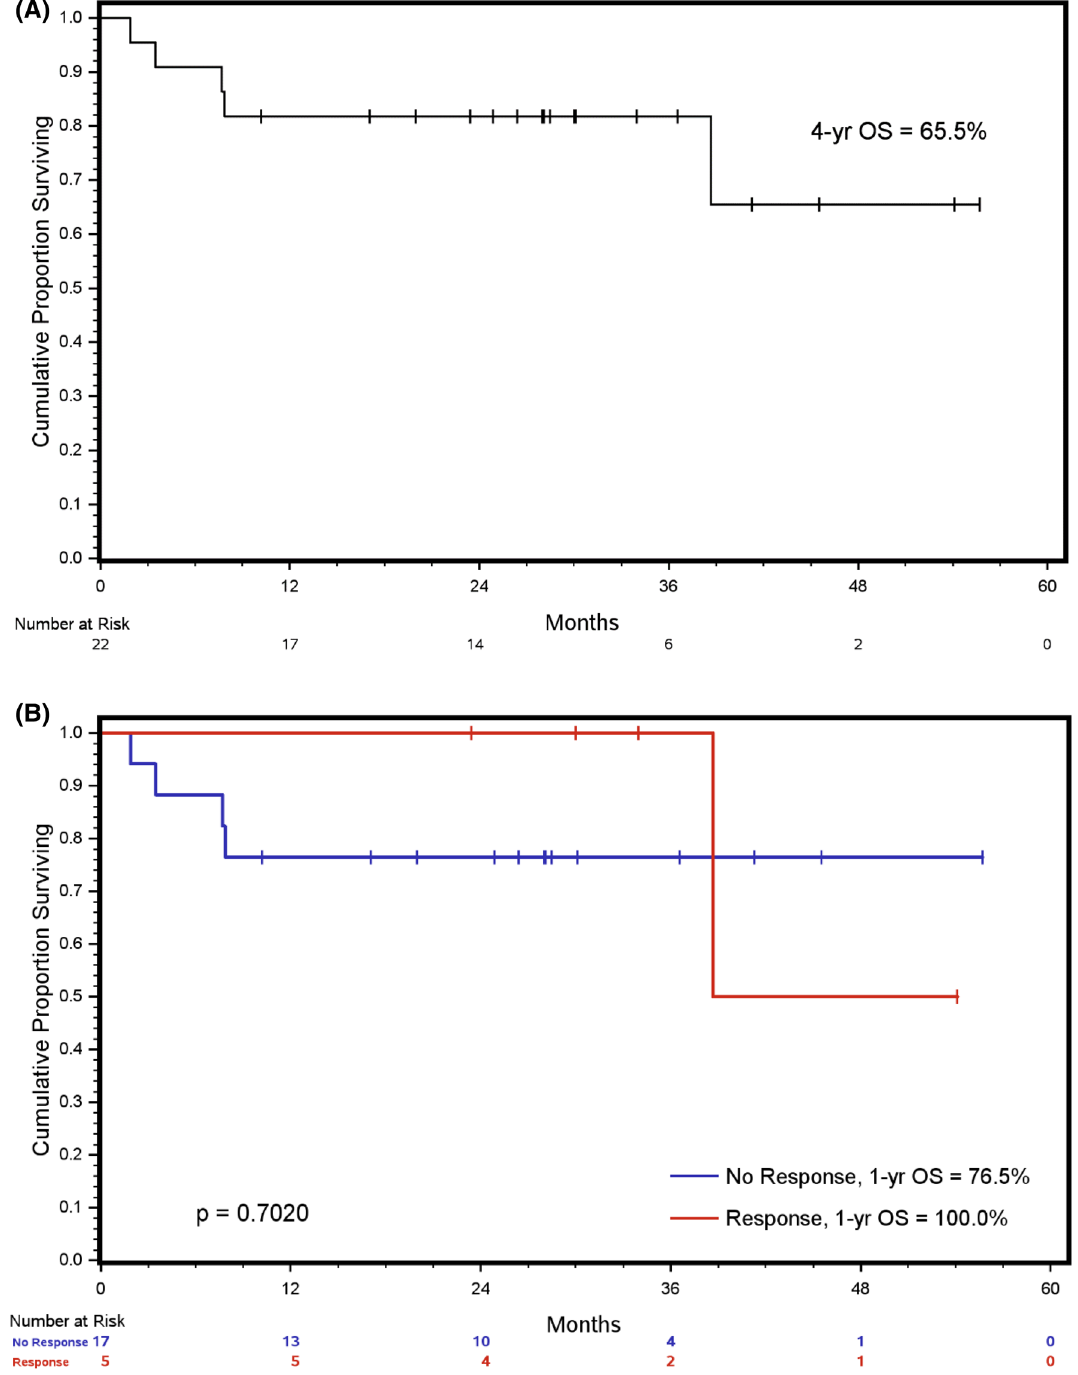
Figure 2. ( A ) OS from the date of first treatment. Estimated OS at 1 year is 81% and 65.5% at 4 years. ( B ) OS in Responders (RCB-I at surgery) vs non-responders (RCB II-III at surgery). (p =